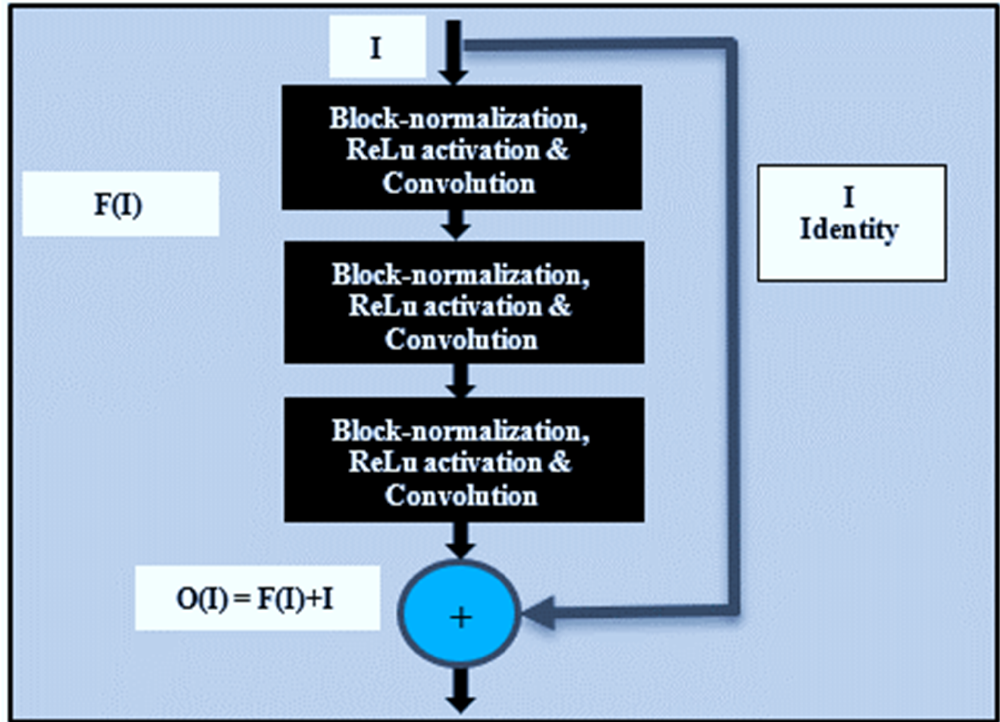
fifth convolutional layers use 384 kernels of dimension 3 × 3 × 256, 384 kernels of dimen- sion 3 × 3 × 192, and 256 kernels of dimension 3 × 3 × 192, respectively, for filtering. Nor- malisation or pooling is not applied to the response of the final three convolutional layers. Figure 5. Steps for pre-processing and organisation of the original dataset for generation of Dataset I and Dataset II. fully connected layers have 4096, 4096, and 1000 connected neurons, respectively.